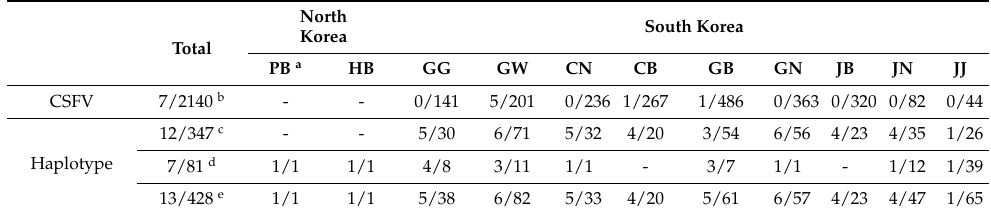
Table 1. Detection of CSFV antigens and haplotype analysis of wild boars.